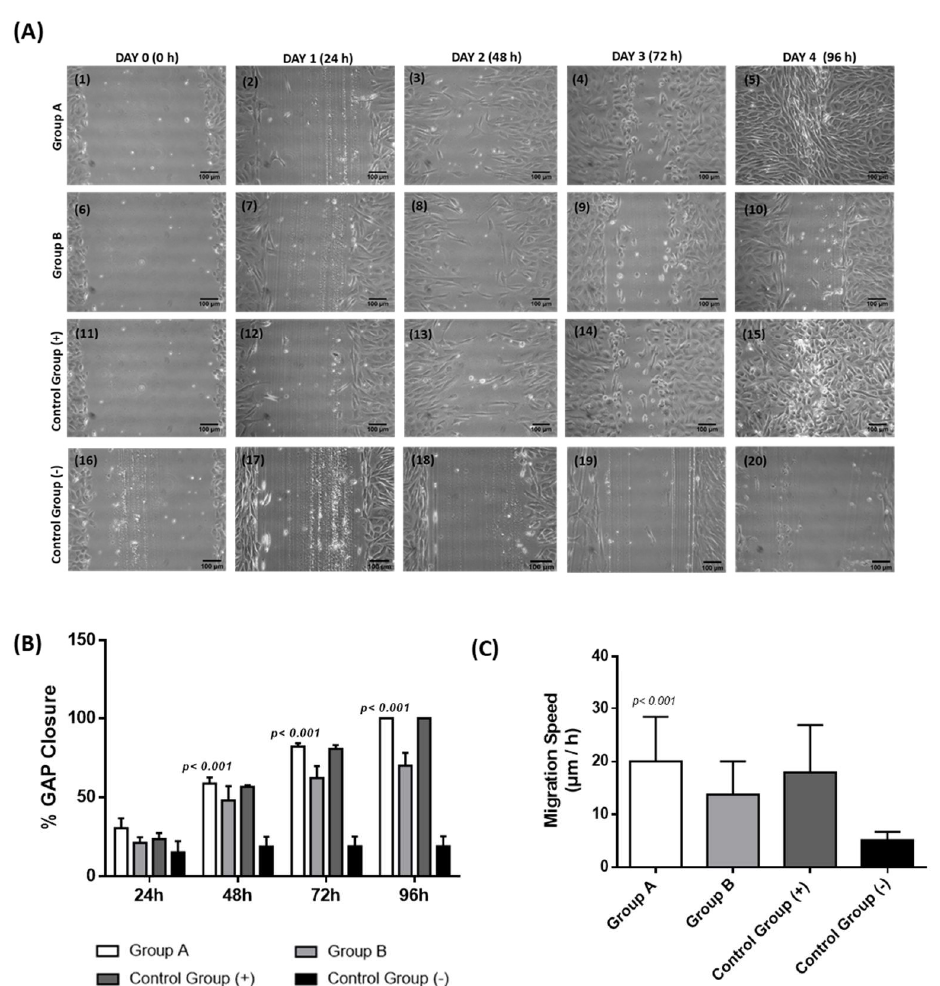
Figure 3. Performance of scratch-wound assay for the determination of the migratory capacity of CECs ( A ). Specifically the migratory capacity of CECs from group A (A1–A5), group B (A6–A10), positive control group (A11–A15), and negative control group (A16–A20), was monitored. All im-